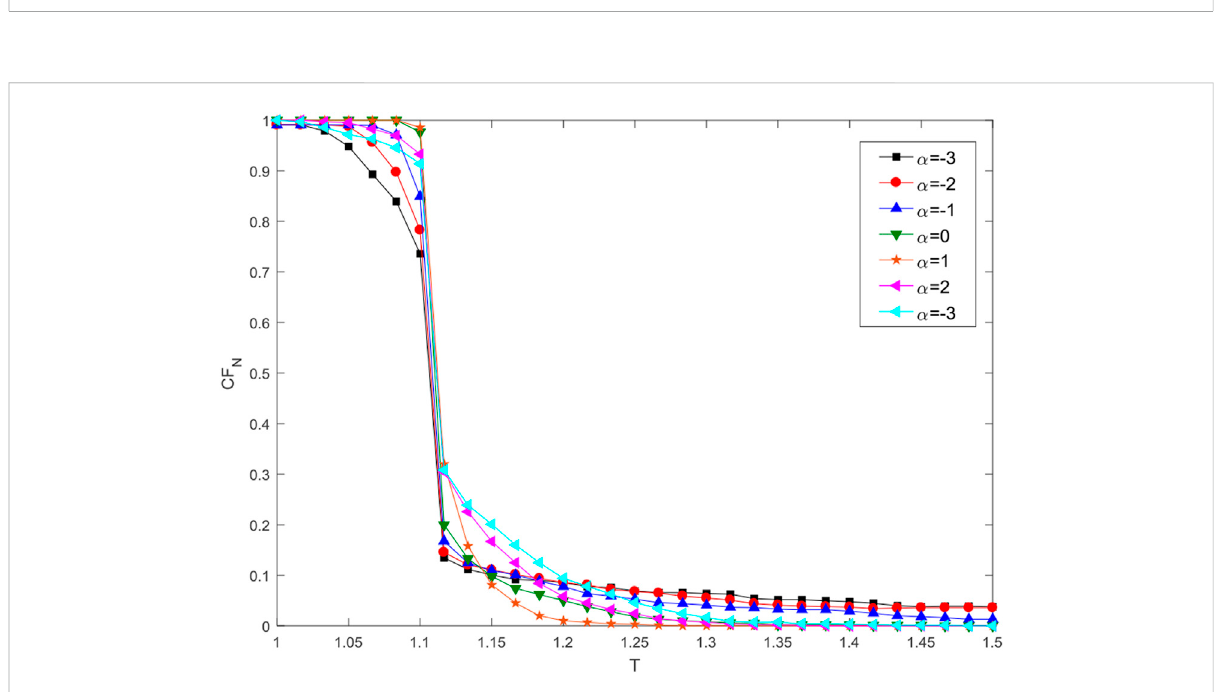
FIGURE 6 Effect of parameter T on the cascading failures performance, with different values of α . β (cid:1) 1 in the